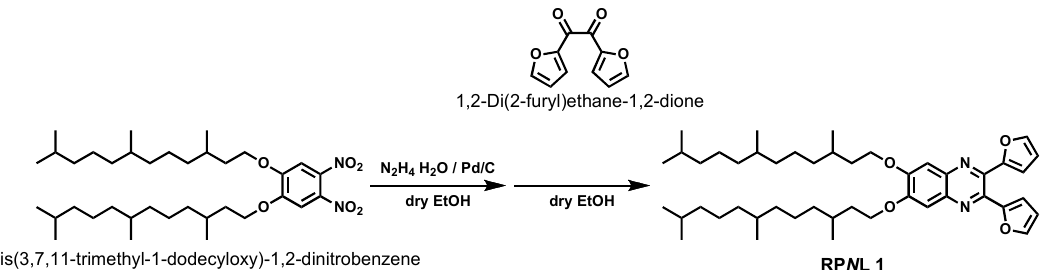
Figure 1. Top and side views of the optimized molecular geometry of ( a ) 6,7-bis(3,7,11-trimethyl-1-dodecyloxy)-2,3-difurylquinoxaline (RP N L 1) and ( b ) RP N L 1 with benzene sulfonic acid (BSA), as calculated at the B3LYP/6-31G* level.